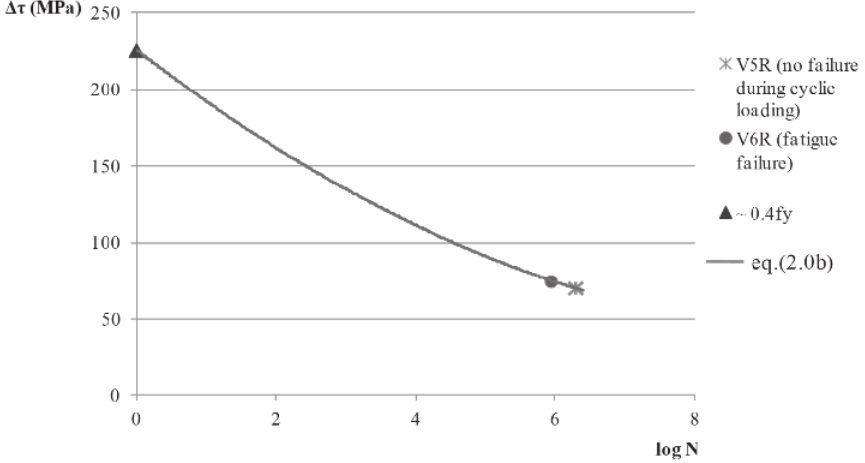
Shear stress variation in beam-jacket interface as a function of the number of cycles given by equation (2.0b)